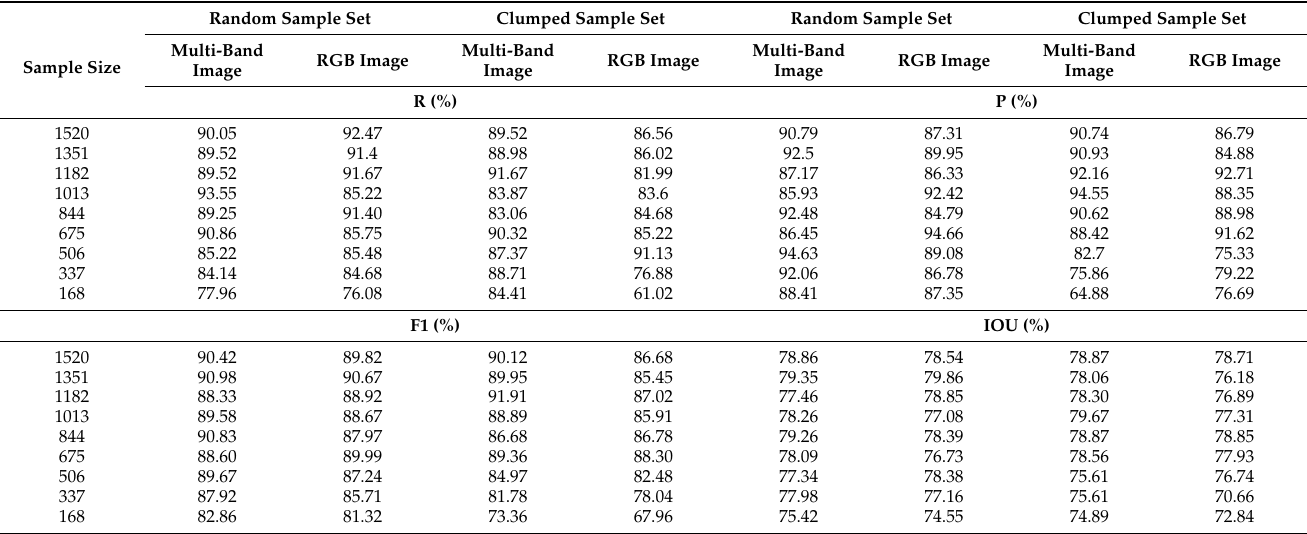
Table 2. Comparison of model performance with different sample sizes and sampling labeling. Sample sizes are sorted in descending order by a percentage of 10%. R, P, F1, and IoU represent recall, precision, F1 score, and Intersection over Union, respectively.